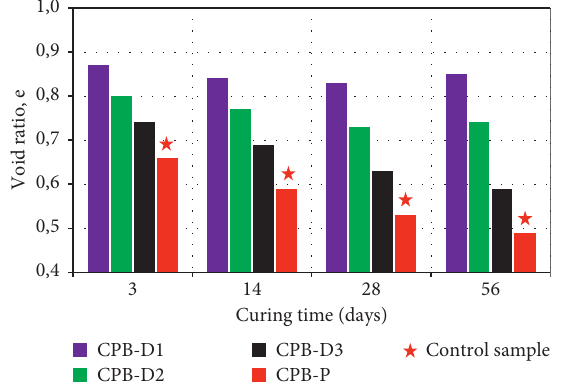
Figure 7: Change in void ratio with time for diverse mine backfills.